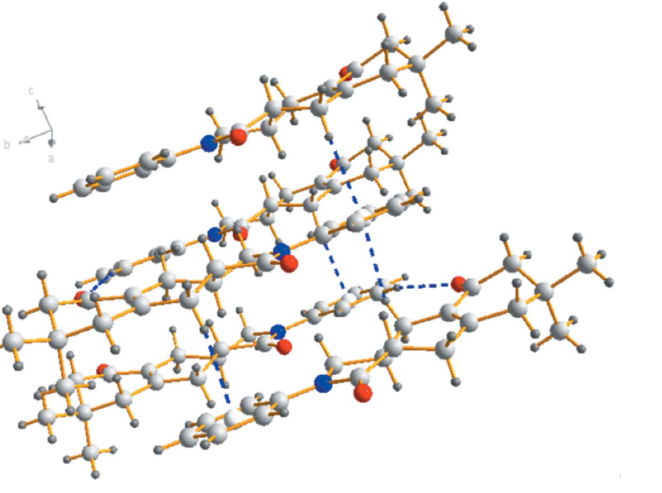
Figure 2 A packing diagram of the title compound. The C—H (cid:2)(cid:2)(cid:2) (cid:2) and C—H (cid:2)(cid:2)(cid:2) O interactions are shown as dashed lines.